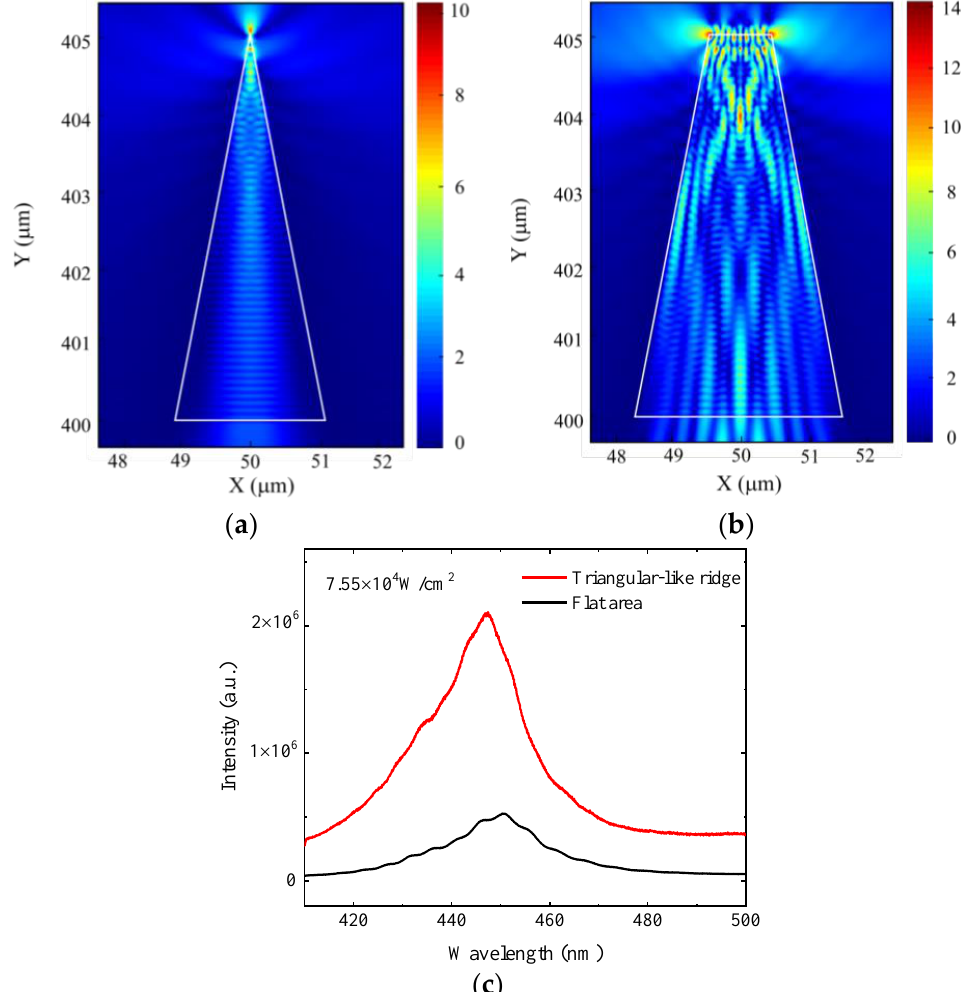
Figure 7. The optical field distribution of ( a ) a triangular ridge and ( b ) a triangular-like ridge with an apex angle of 26.8°, (c) The PL spectrum of the triangular-like ridge and flat area.